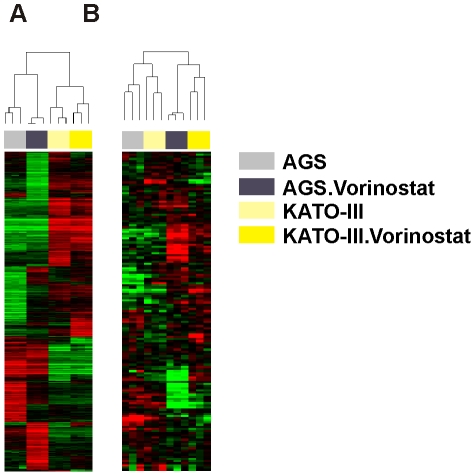
Hierarchical Clustering Gene expression analysis of gastric cancer cell lines after vorinostat treatment.(A) Unsupervised hierarchical clustering of gene expression data from AGS and KATO III before and after 5 µM vorinostat treatment for 48 hours. Genes with an expression level that has at least 2-fold difference relative to median value across cell lines in at least 2 arrays were selected for hierarchical clustering analysis (3,646 gene features). (B) Supervised hierarchical clustering with autophagy related genes (149 probes) of AGS and KATO III after vorinostat treatment.